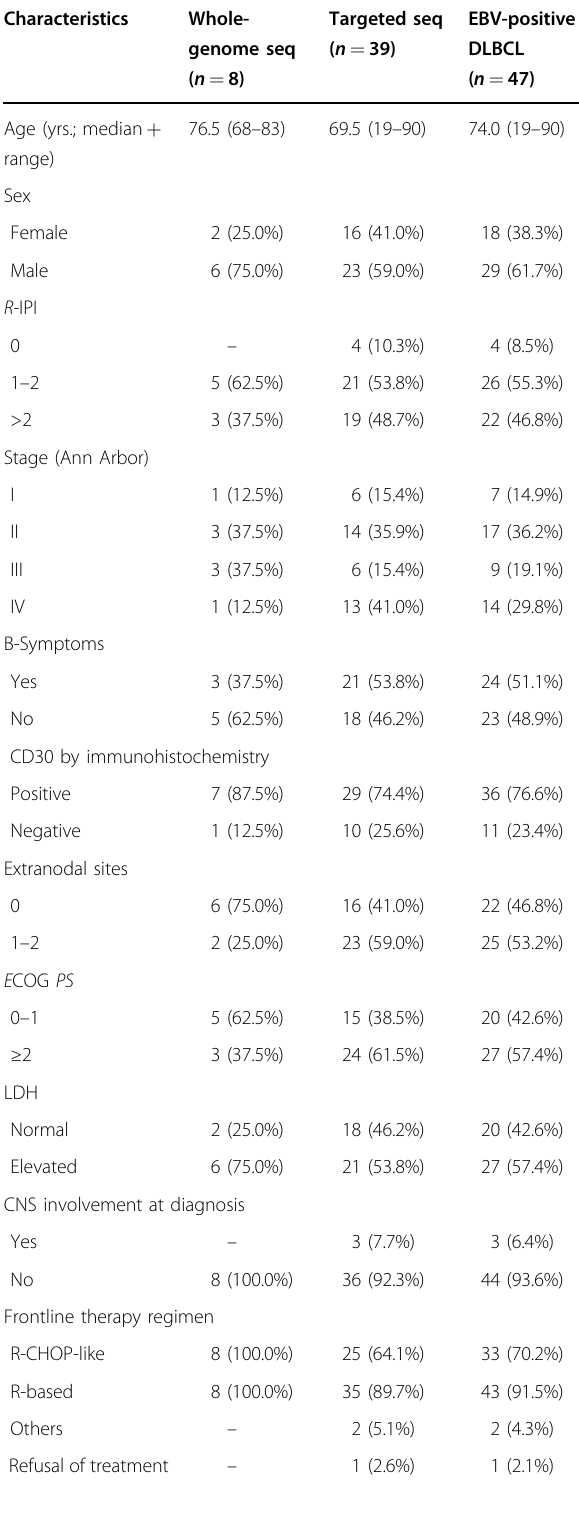
Table 1 Baseline clinicopathological characteristics in patients with EBV-positive